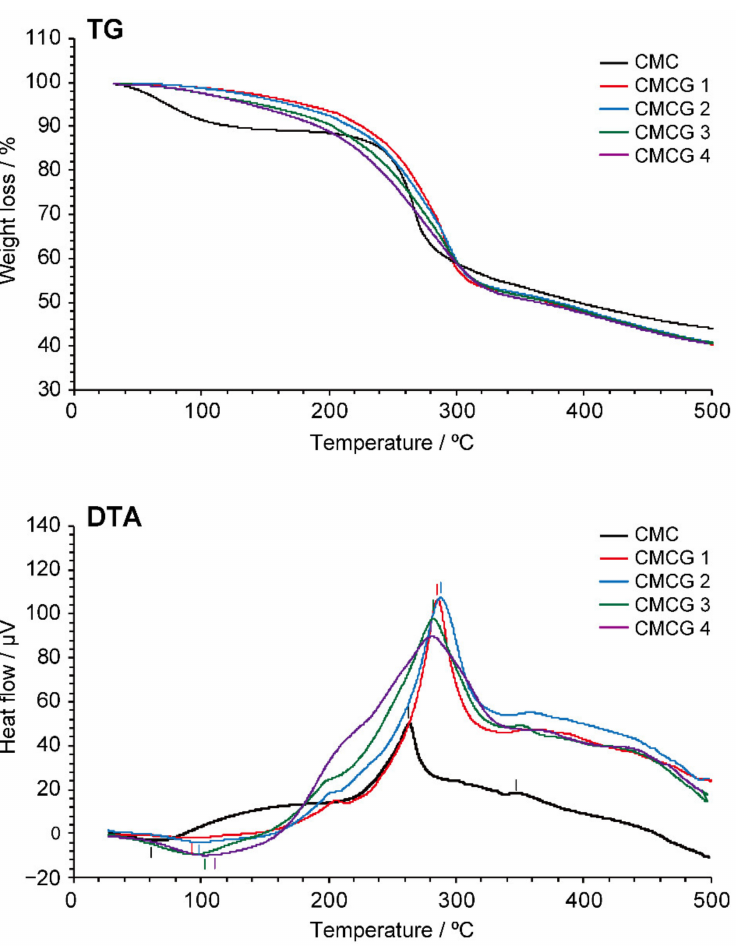
Figure 8. Thermogravimetric (TG) and differential thermal analysis (DTA) traces for CMCG 1–4 and